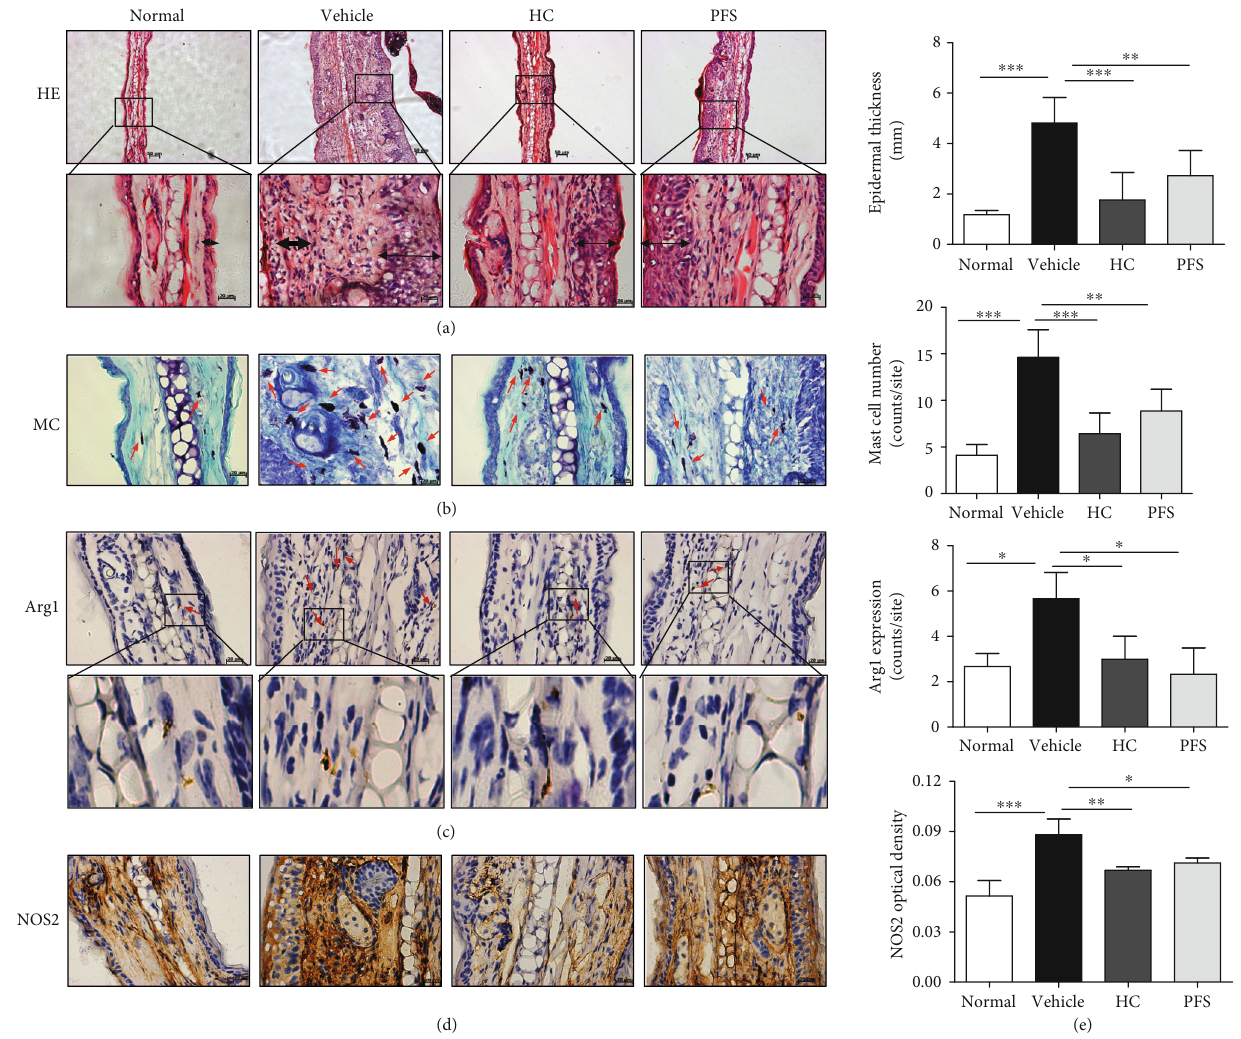
Figure 3: PFS improved the histology of atopic dermatitis (AD) in mice (ten-time challenge). Tissues were excised, fi xed in 10% formaldehyde for 1 h, embedded in OTC, and sectioned. (a) HE staining (100x; 400x); arrow indicates epidermal exfoliation; (b) toluidine blue staining (400x); arrows: mast cells; (c) Arg1 (100x; 400x); arrows: Arg1-positive macrophages; (d) NOS2 (400x); (e) epidermal thickness, number of mast cells, Arg1-positive cells, and NOS2 optical density were detected. ∗ p < 0 : 05 and ∗∗ p < 0 : 01 versus the vehicle